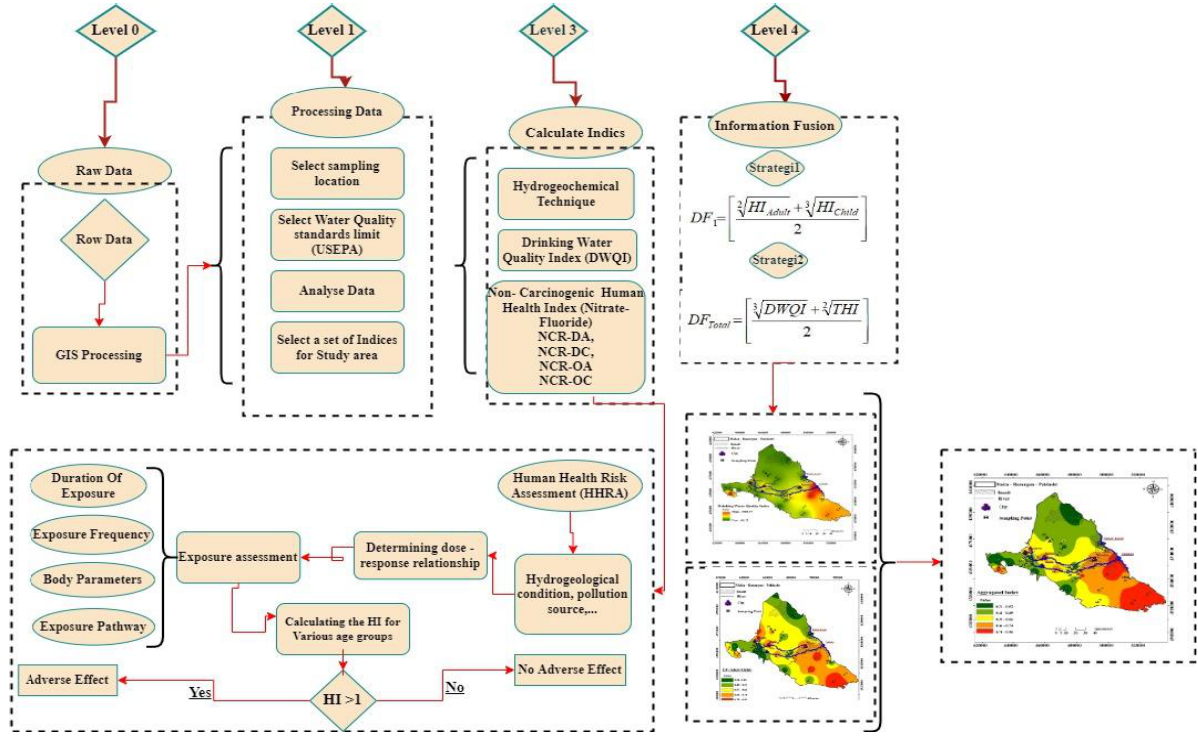
Figure 1. Flowchart of the planned information fusion-based human health risk assessment frame- work.